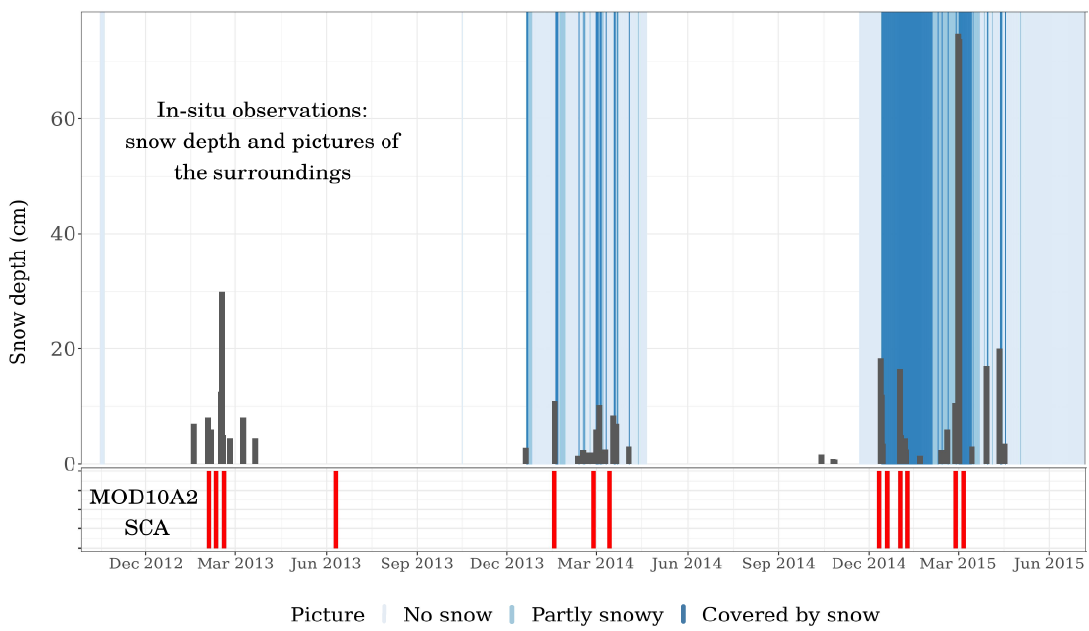
Figure 8. Three sources of data for snowpack description at the location of the Khunde snow plate between December 2012 and July 2015: (1) in black lines, the snow depths (in cm) measured at the snow plate by the observers; (2) in blue, the photos taken by the observers around the snow plate classified as “no snow” (light blue), “partially covered,” and “covered by snow” (dark blue). No blue bar means that no photo was taken for these dates. The red bars indicate the MOD10A2 dates for which the pixel that contains the Khunde snow plate was determined to be covered by snow.